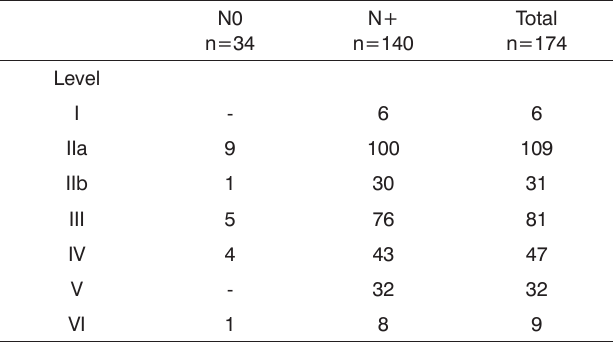
Table 3. Distribution of ipsilateral histological metastases (pN).